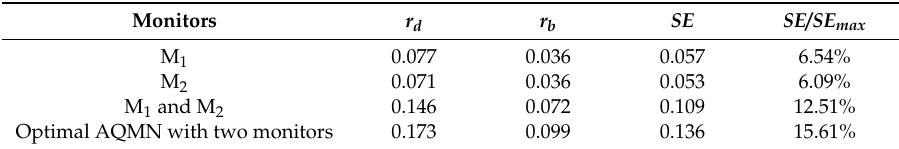
Table 1. Score performance of two existing monitors and optimal AQMN (air quality monitoring network) with two monitors.